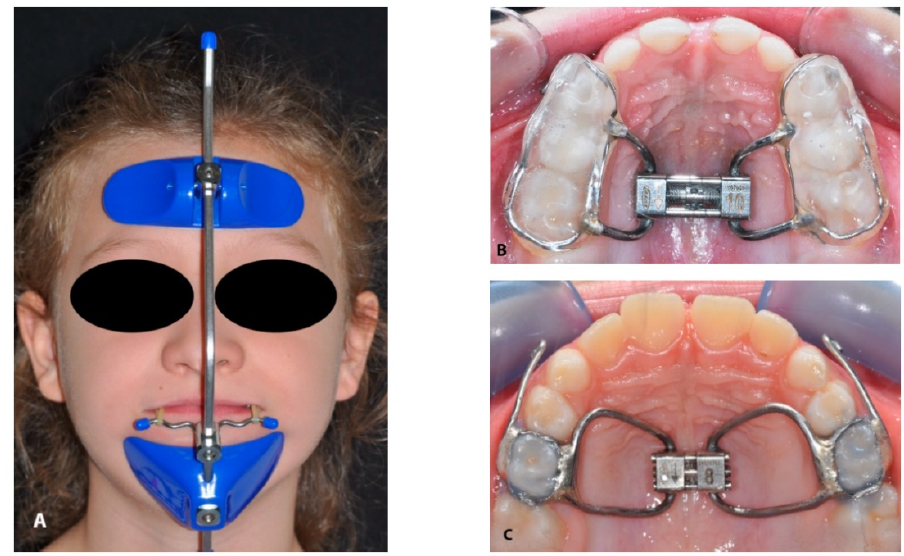
Figure 2. Facemask ( A ) and bonded ( B ) and banded ( C ) Hyrax maxillary expansion appliances.